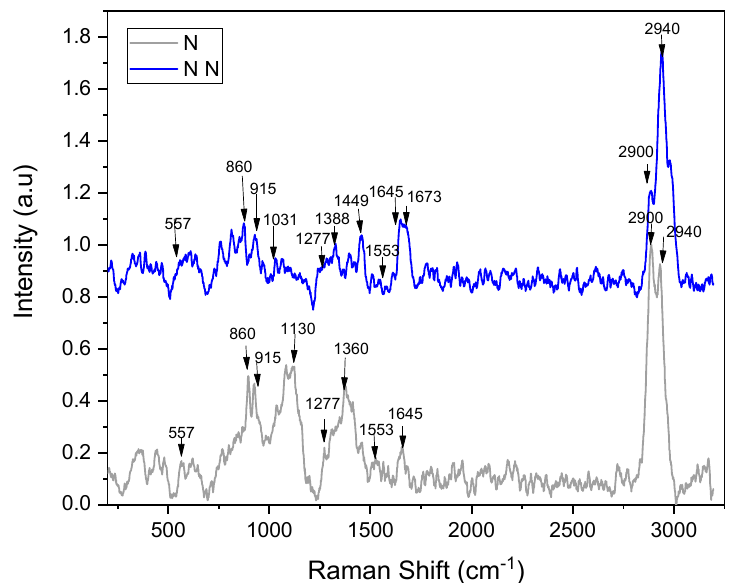
Figure 3. Raman spectra of neutralized (N) and non-neutralized (NN) AH-crosslinked CHT. It has been reported that when using a 1064 nm laser, chitosan shows absorption bands at 2885 cm − 1 , 1419 cm − 1 , 1376 cm − 1 , 1116 cm − 1 , 900 cm − 1 , 491 cm − 1 , and 424 cm − 1 [40]. Only some of these vibrations were observed with the 633 nm laser. Absorptions in the 2800–3000 cm − 1 interval are derived from CH and CH 2 or even CH 3 bond stretching [41], whereas those in the 1000–1200 cm − 1 interval indicate ẟ (C–C) and C–O–C band stretching [42]. The peaks at 1449 cm − 1 and 1388 cm − 1 can be assigned to the bending of CH groups in the pyranosidic skeleton. However, they have sometimes been associated with C–O–H stretching bonding, as reported by Schauenberg et al.[43]. The absorption of amide I observed at 1645 cm − 1 and the band at 1553 cm − 1 were of low intensity in Raman spectra in contrast to those observed in the infrared spectra, demonstrating that crosslinking with ammonium hydroxide was occurring. Interestingly, when the scaffold was neutralized, a split appeared in the signal at 2900 cm − 1 and 2940 cm − 1 . On the other hand, the absorptions at 1360 cm − 1 and 1130 cm − 1 were observed to be more intense. 2.2.5. Thermogravimetric Analysis (TGA) The thermal stability of the sample was evaluated by determining the starting tem- perature of the degradation stage of the ammonium-hydroxide-crosslinked chitosan scaf- folds and the maximum temperature during decomposition. Figure 4 shows the TGA thermograms of the chitosan foams. In the neutralized NH 4 OH-crosslinked chitosan scaffolds, the decomposition temperature (Td) was ob- served at 285 °C (Table 2). On the other hand, the decomposition temperature of the non- neutralized NH 4 OH-crosslinked chitosan foam was observed at 316 °C (Table 2). These results suggest higher thermal stability in non-neutralized foams as the regenerated